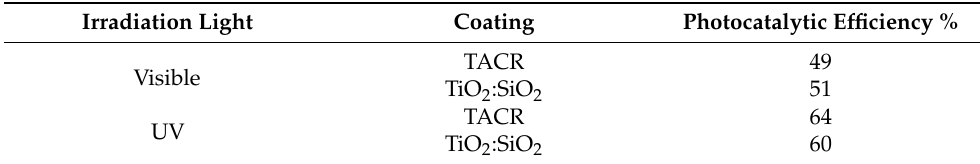
Table 5. Comparison between different TiO 2 -based photocatalysts. Tests carried out with SP fabrics under UV and visible light.